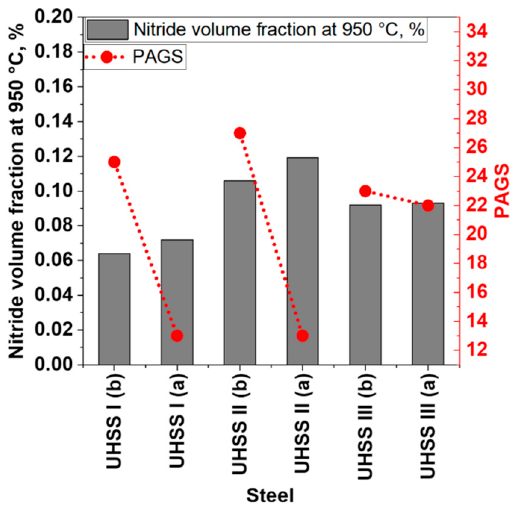
Figure 10. Correlation between the predicted equilibrium volume fraction of nitrides at the forging finish temperature (950 °C) and the PAGS without ( b ) and with ( a ) ESR.